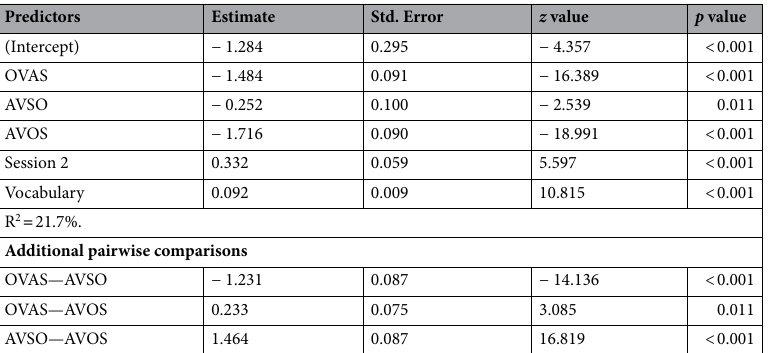
Table 3. Results for the fixed effects from the binomial generalized linear mixed-effect-based model of the performance on the picture selection task; results from the post-hoc pairwise comparisons between the remaining conditions are presented at the bottom of the table. SVAO and session 1 were coded as the reference